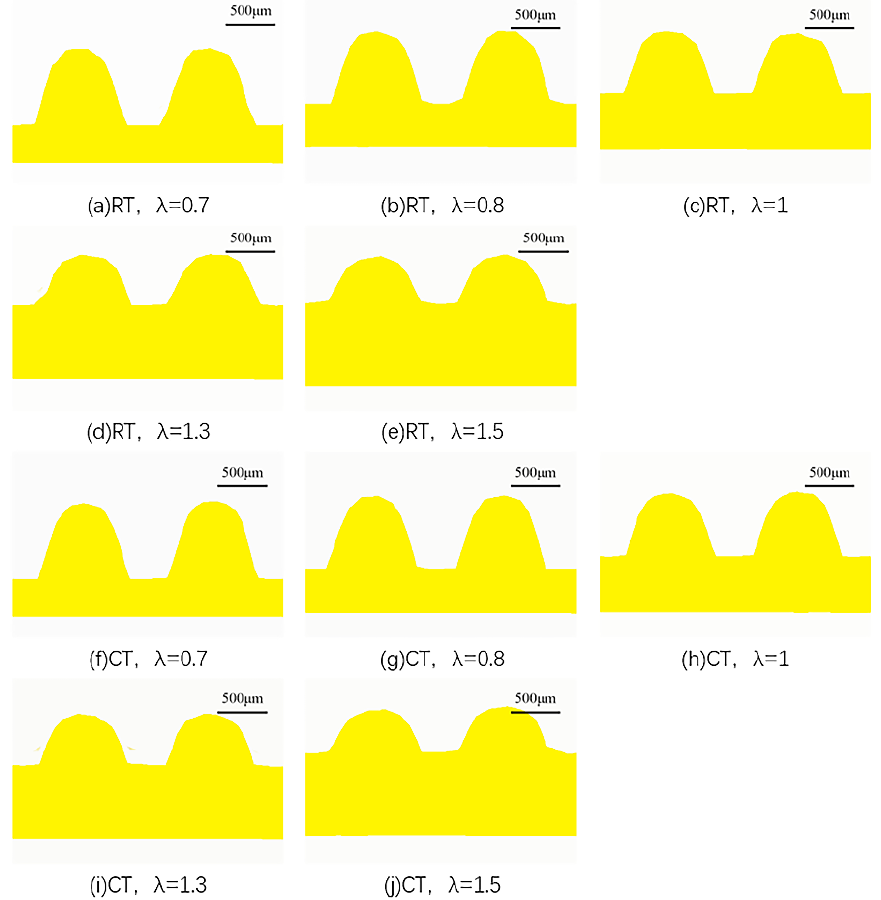
Figure 8. Cross-sectional area of three-dimensional morphology of micro-groove fins produced by extrusion machining under different conditions.